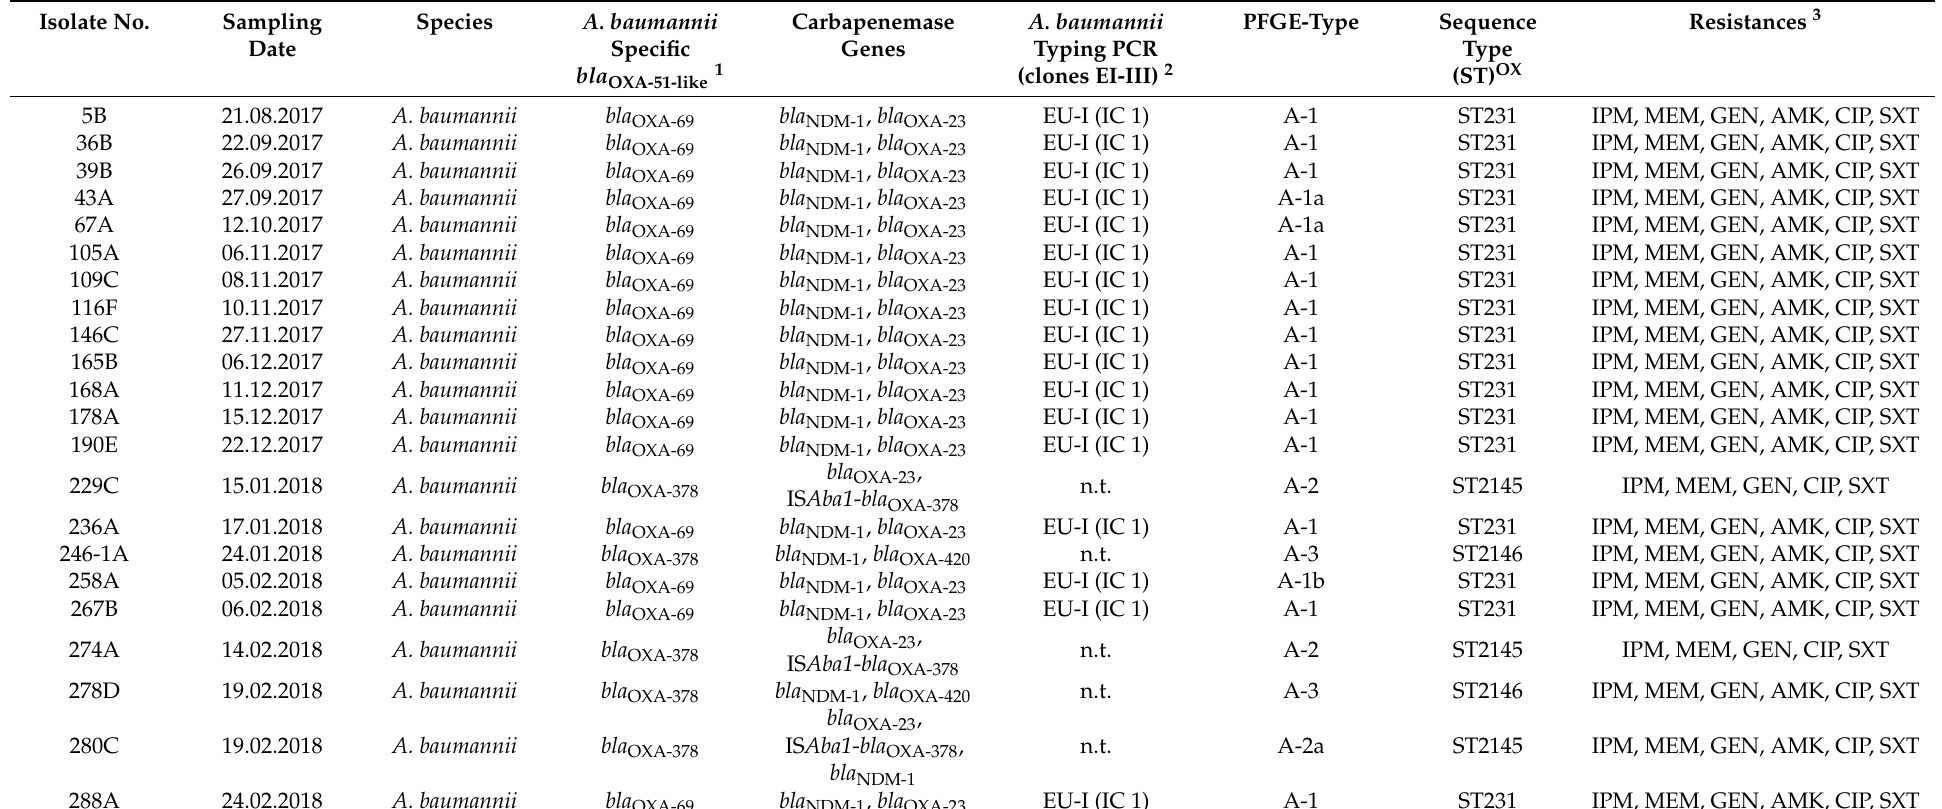
Table 2. Characteristics of 22 carbapenem-resistant Acinetobacter baumannii isolates from wound infections, Ghana, 2017/2018. Isolate